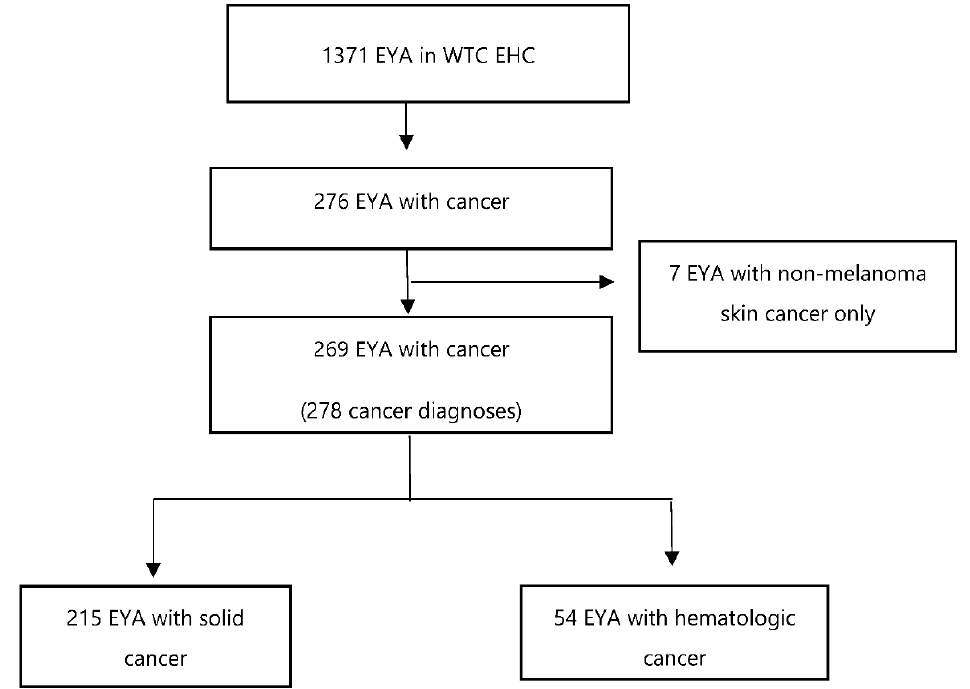
Figure 1. Distribution of cancers in WTC survivors who were exposed at a young age (EYA) enrolled in the WTC EHC as of 31 July 2021.